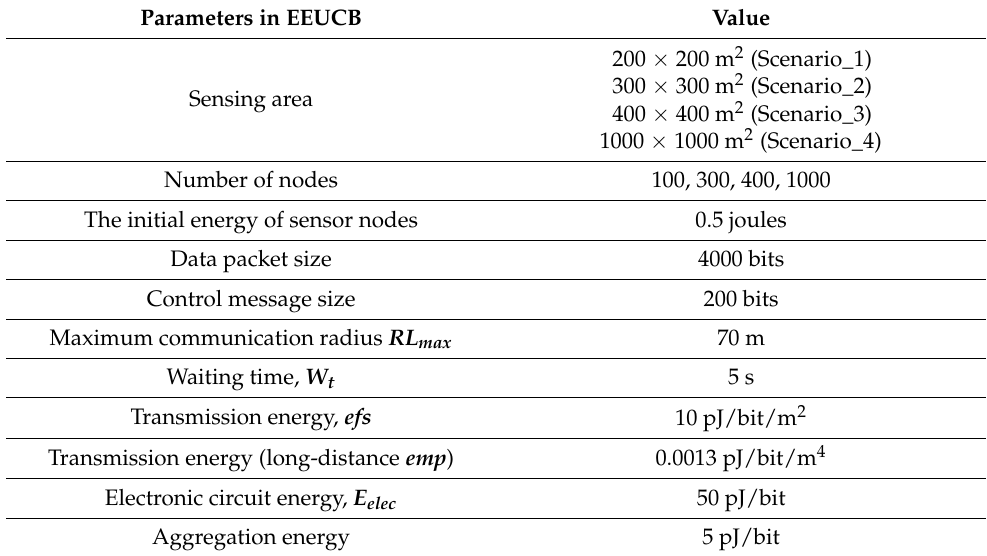
Table 4. Parameters of